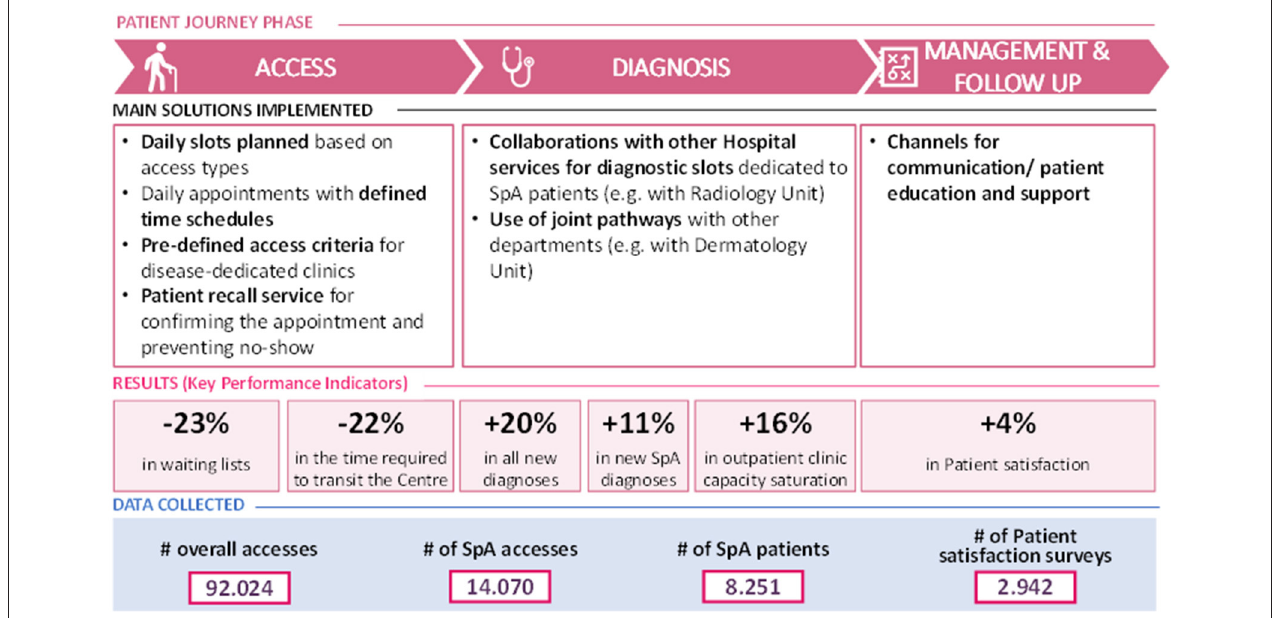
FIGURE 3 | Synthetic overview of the “Early SpA Clinic”